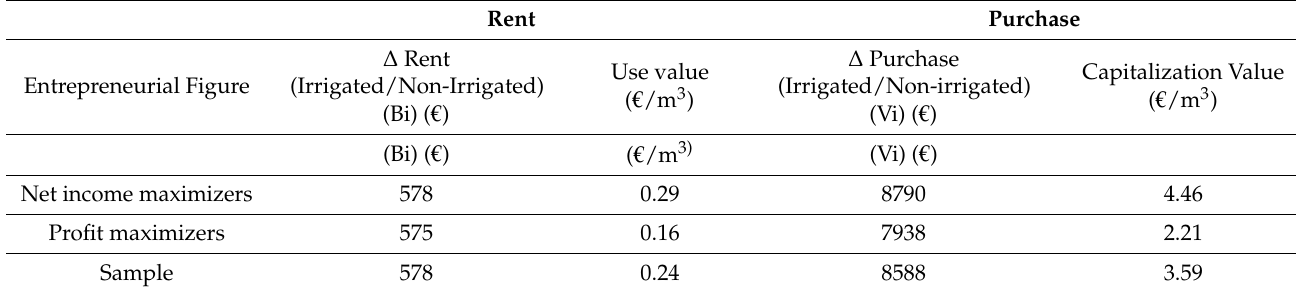
Table 7. Water monetary value estimation.